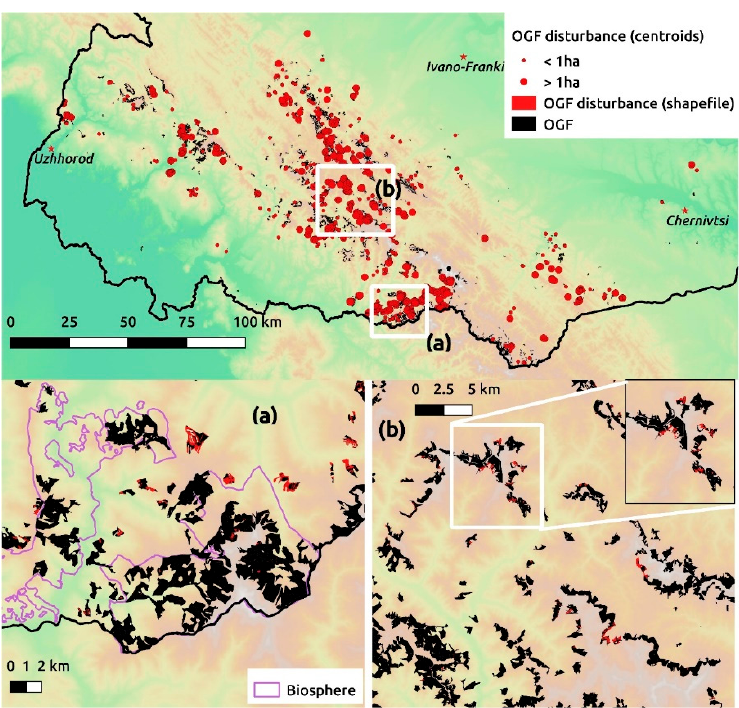
Figure 6. Distribution of old-growth forest (OGF) and OGF disturbances over the period 2010 to 2019. Shaded area highlights ( a ) Northwest Maramures and ( b ) north Svydovets ridge, Bratkovsky ridge and Bushtul massif. Biosphere in ( a ) shows outline of UNESCO Biosphere reserves.